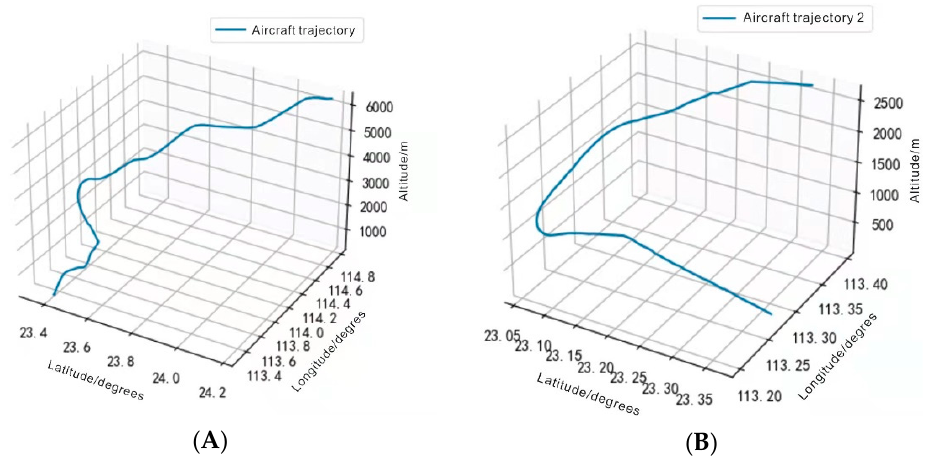
Figure 3. Valid trajectory. ( A ) Valid trajectory at higher altitudes. ( B ) Valid trajectory at lower altitudes.